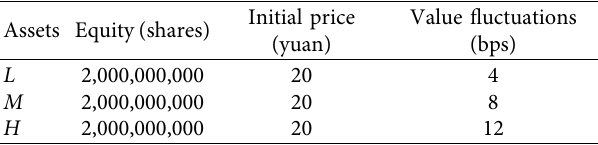
Table 1: Design of the spot underlying assets in the agent-based model.